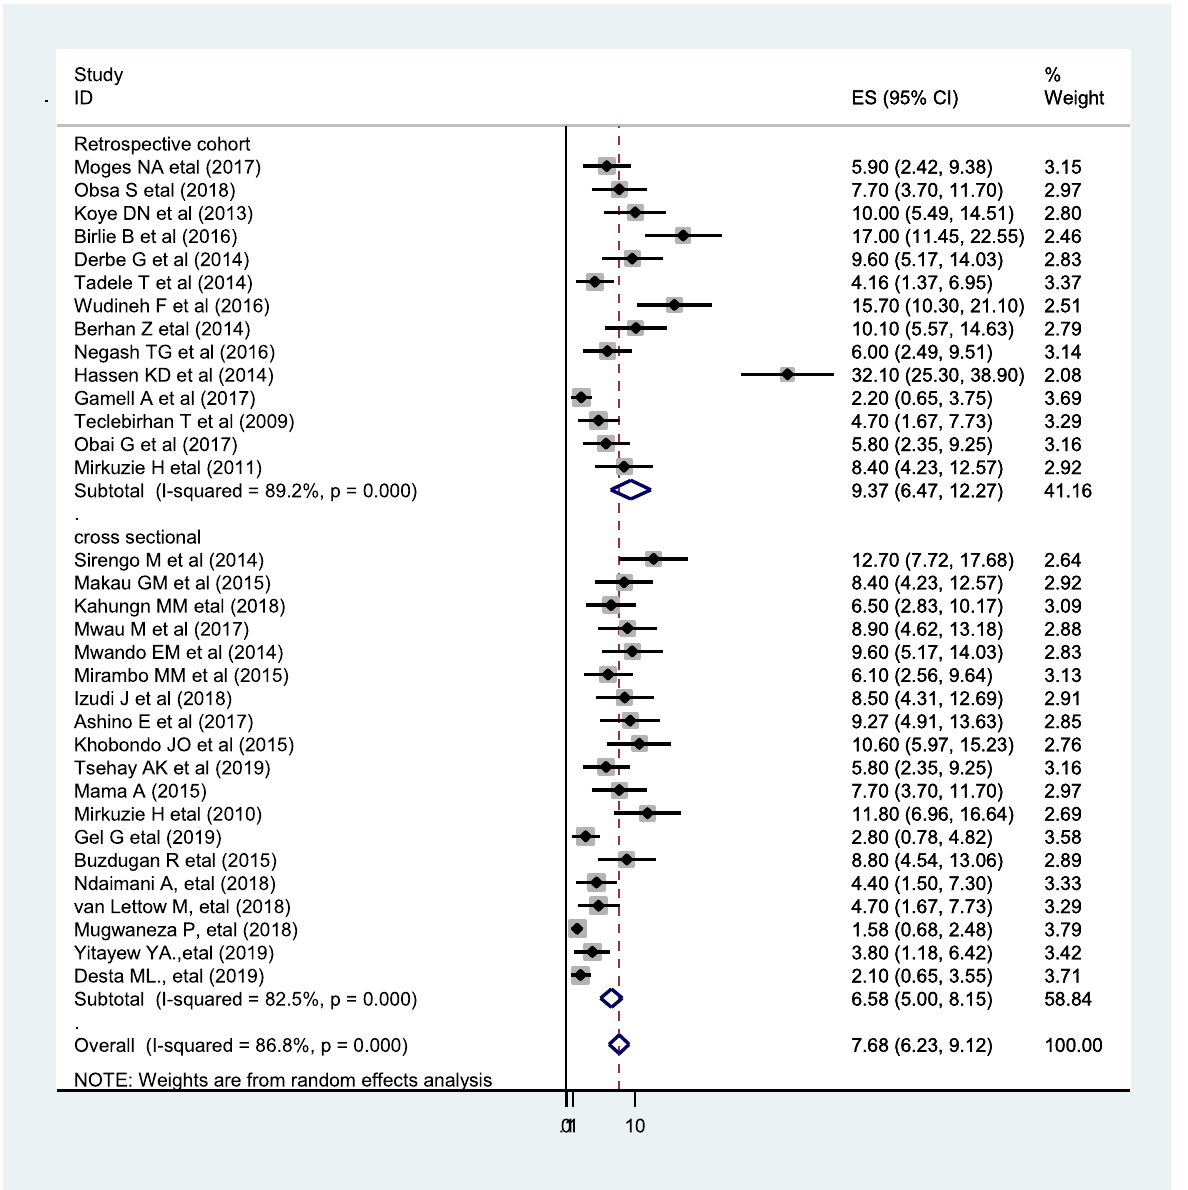
Fig. 3 Forest plot of the prevalence with corresponding 95% CIs of sub-group analysis by the study design of the twenty-seven studies on vertical HIV infection in East Africa. The midpoint and the length of each segment indicated prevalence and a 95% CI whereas the diamond shape showed the combined prevalence of all